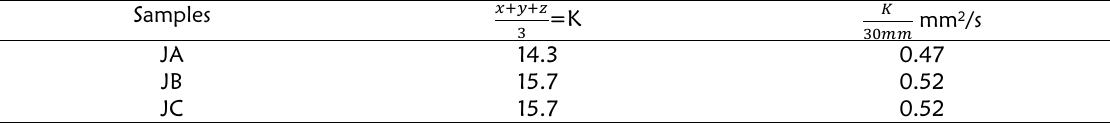
Table 6: Viscosity values for samples JA, JB and